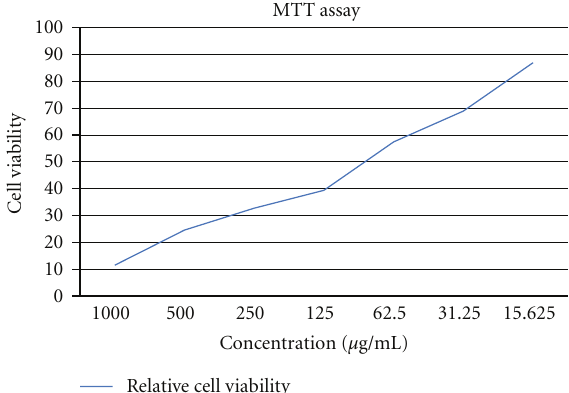
Figure 3: Relative cell viability of MCF-7 cells at di ff erent concen- tration of anthocaynin extracted by acidified